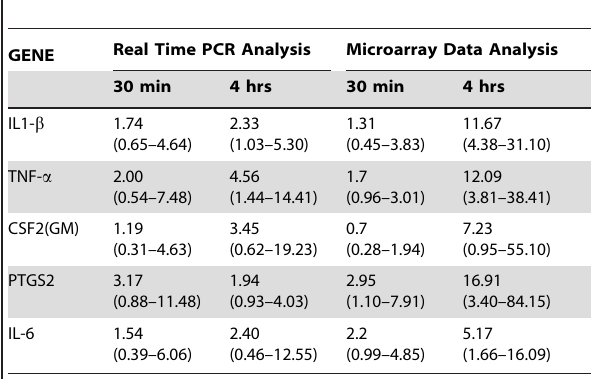
Table 1. Validation of transcript expression of L. (V.) panamensis -infected human monocyte-derived macrophages.